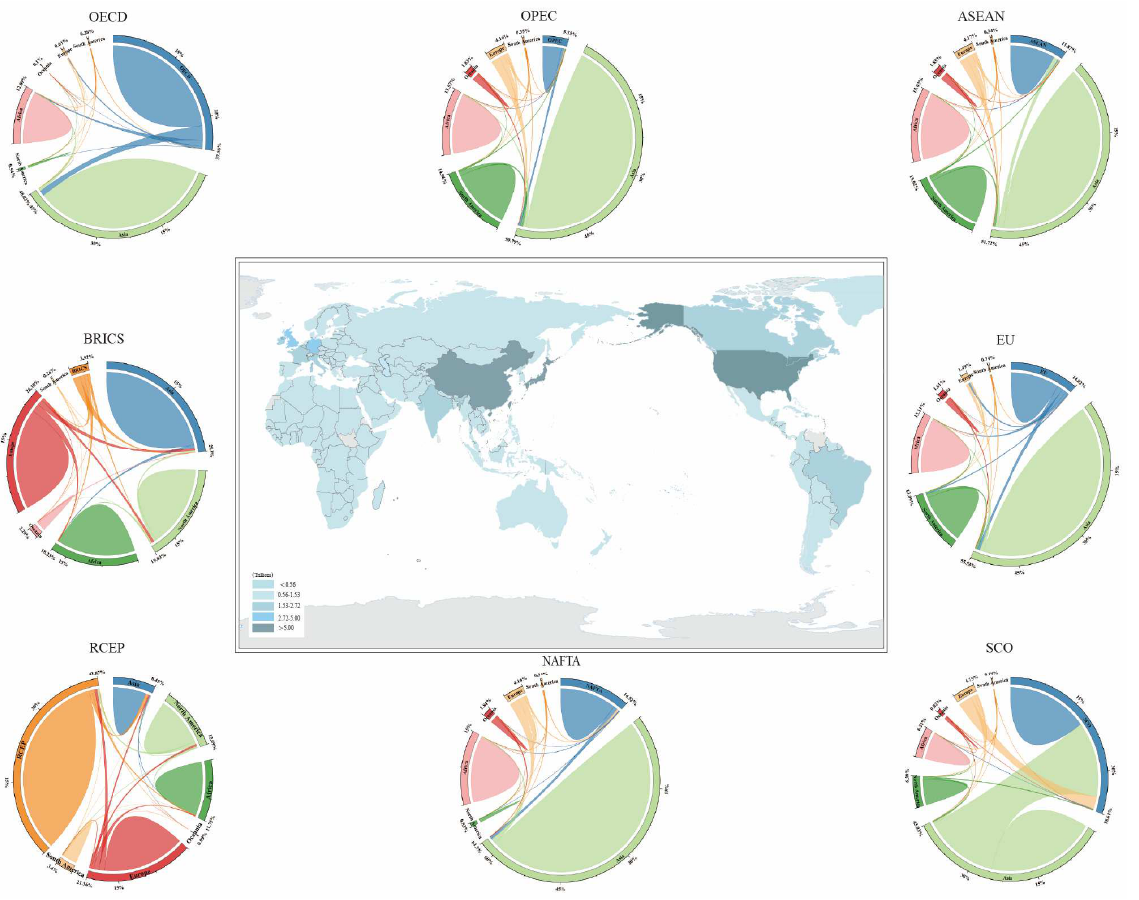
Figure 2. Maps of global GDP (in current dollars) and embodied carbon transfers among eight major economic cooperation organizations.